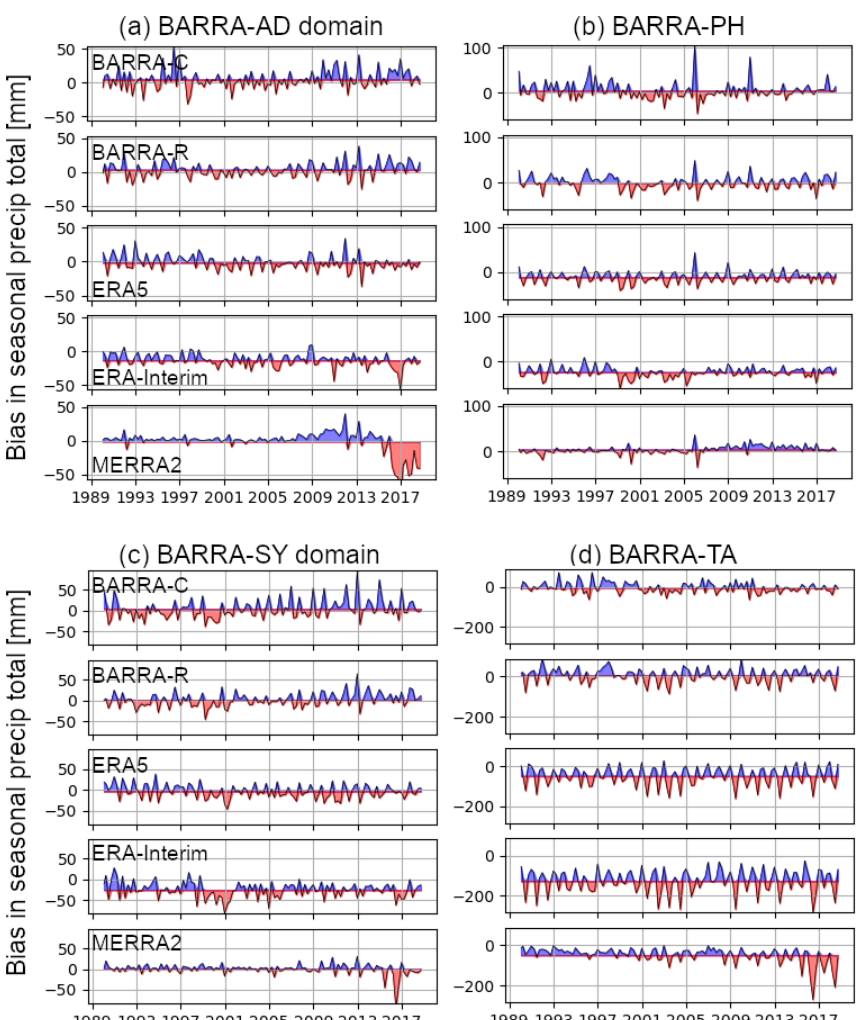
Figure 8. Mean difference in seasonal precipitation totals over various BARRA-C domains with respect to AWAP. Black curves are shaded around the 1990–2018 means. Note that the y axes in (a–d) are